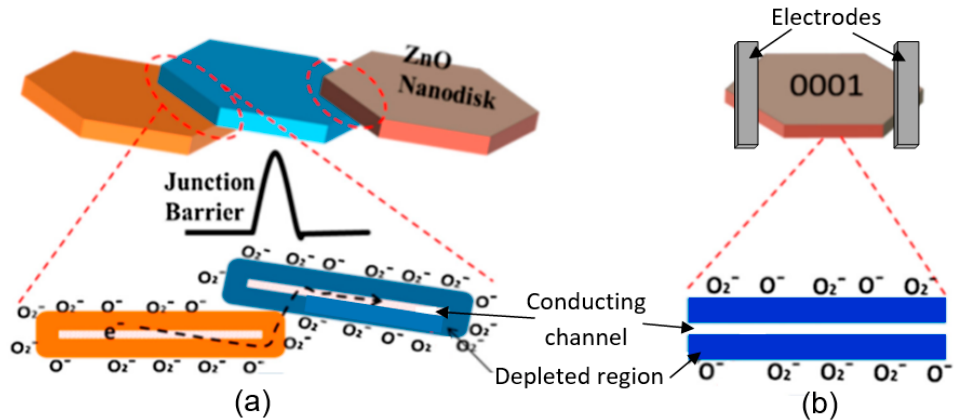
Figure 44. Schematic representation of the sensing mechanism in ZnO gas sensors fabricated using ( a ) a stack of ZnO nanodisks and ( b ) an individual nanodisk. Reproduced with permission from Alenezi et al. [402]. Copyright 2014: American Chemical Society.